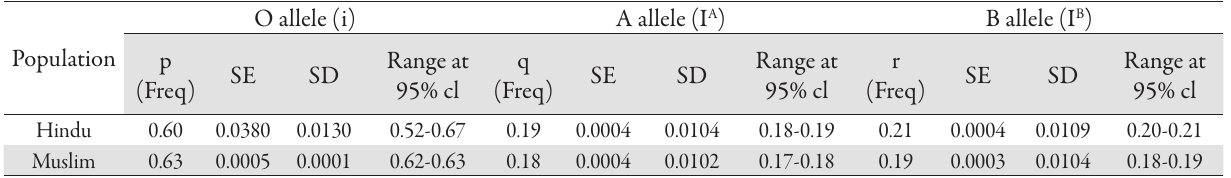
Tab. 2. Estimates of allele frequency and descriptive statistics of ABO alleles in Hindu and Muslim populations of Barak Valley